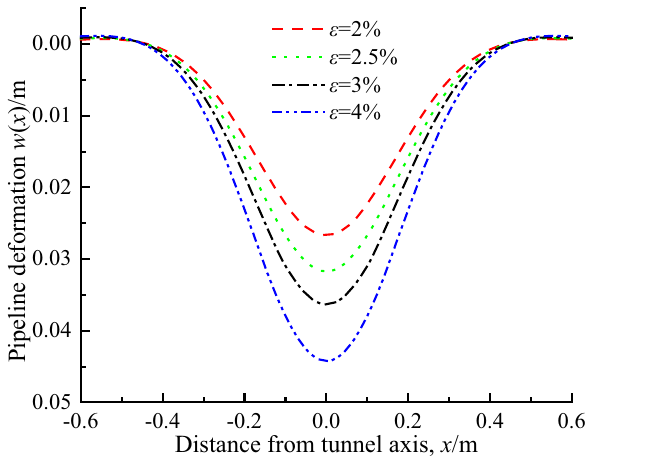
Figure 14. Pipe deflection under different soil loss.